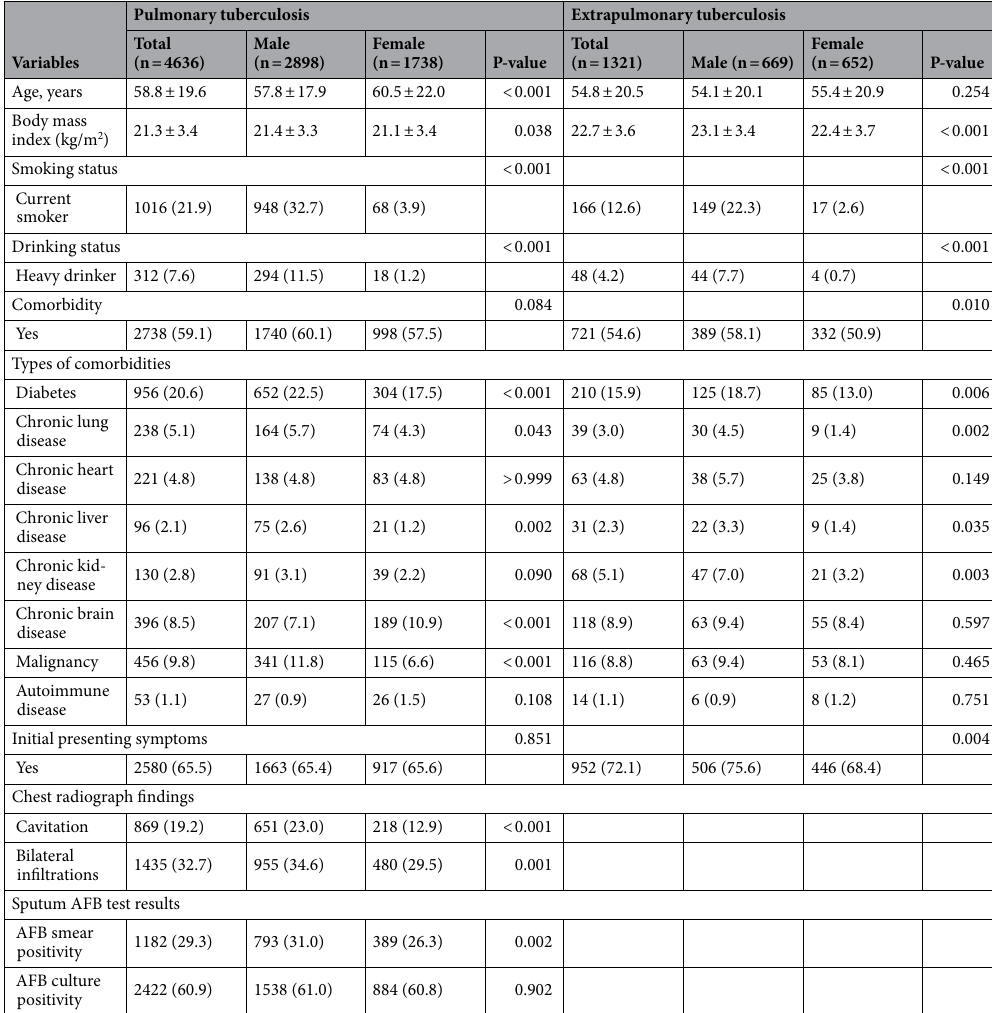
Table 2. Baseline characteristics of enrolled participants with pulmonary and extrapulmonary tuberculosis stratified by sex. AFB acid-fast